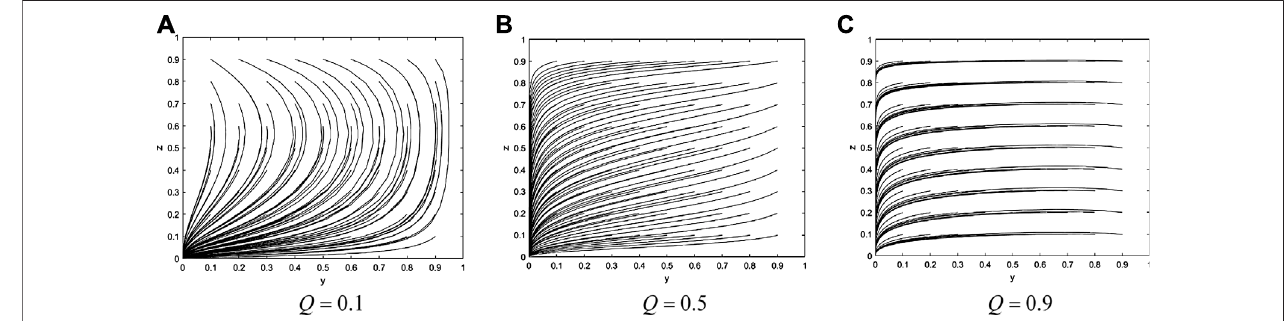
FIGURE 8 | Convergence phase diagram of the game system with different Q values. (A) Q = 0.1; (B) Q = 0.5; and (C) Q = 0.9.